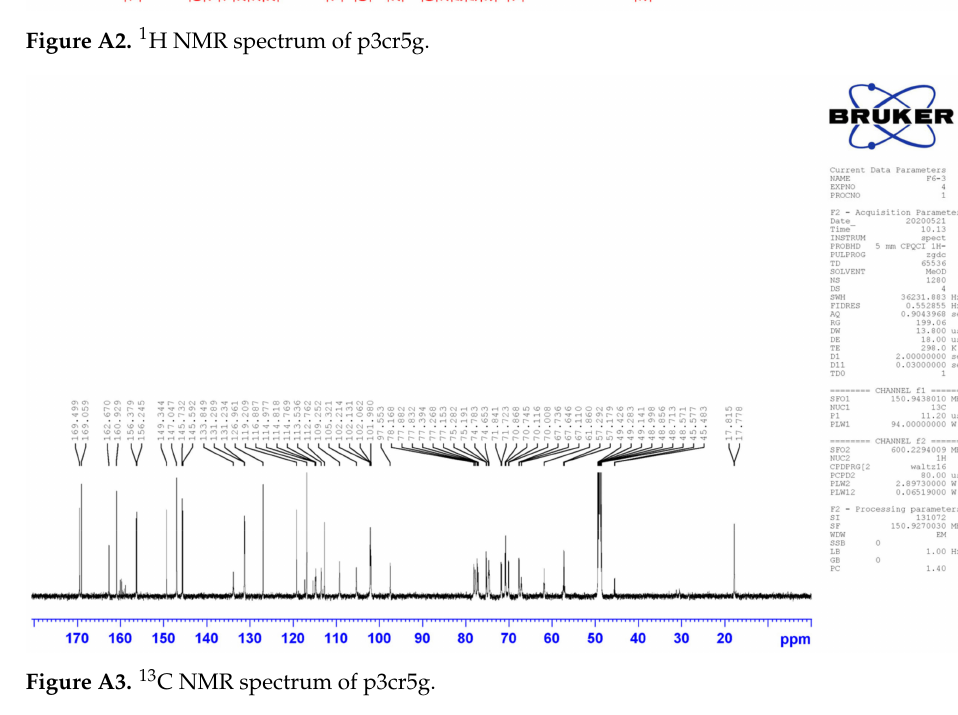
Figure A3. 13 C NMR spectrum of p3cr5g.